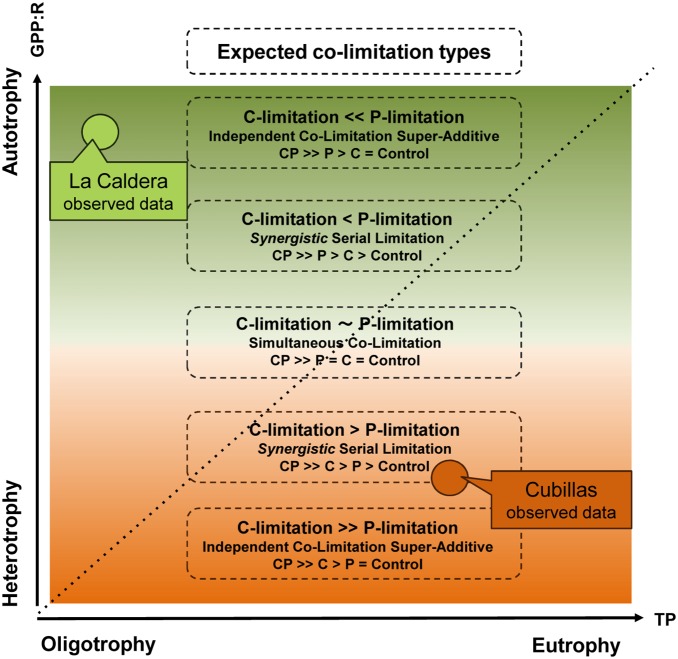
Theoretical diagram of expected types of C and P co-limitation of bacteria based on the trophic-nature gradient.The diagram represents the different types of expected co-limitation according to the trophic-nature gradient (Y-axis), indicated by the colour gradient from dark brown (maximum heterotrophy) to dark green (maximum autotrophy). The diagonal dashed line arrow crossing the diagram represents the trophic-state gradient (X-axis) in the sense of more autotrophy more eutrophy, as found in [32], which does not reflect the major role of trophic-nature gradient found in the present study. The squares with dashed lines include: (i) the single resource expected to be more limiting, according the trophic nature axis; (ii) the name of the expected co-limitation type sensu
[47], and its meaning as effects of the treatments. The circles represent the position found for the ecosystems according to both axes; brown circle is the hetero-eutrophic ecosystem (Cubillas), green circle is the auto-oligotrophic ecosystem (La Caldera).